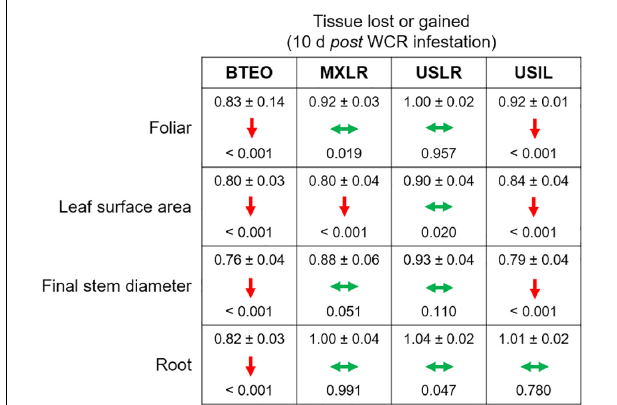
FIGURE 5 | Effects of herbivory by Western corn rootworm on plant tolerance variables in four plant types, ordered from most ancestral to most derived: Balsas teosintes (BTEO), Mexican maize landraces (MXLR), US maize landraces (USLR), and US inbred maize lines (USIL). The plant tolerance variables are mean ratios (= Western corn rootworm-infested plants/non-infested plants) of final stem diameters, foliar weights, leaf surface areas, and root weights. One-sample t -tests were used to compare mean ratios for each plant type against expected ratio of 1.0, which indicates tissue compensation (i.e., no tissue lost or gained in Western corn rootworm-infested plants relative to non-infested plants); the mean ratio ( ± SE) and P- value are shown within each cell. Within each cell, double-pointed, horizontal green arrows indicate compensation (mean ratio does not differ from 1.0), and downward, red arrows indicate undercompensation (mean ratio < 1.0). Critical P for each t -test was set at P ≤ 0.012, per Sidak’s correction.